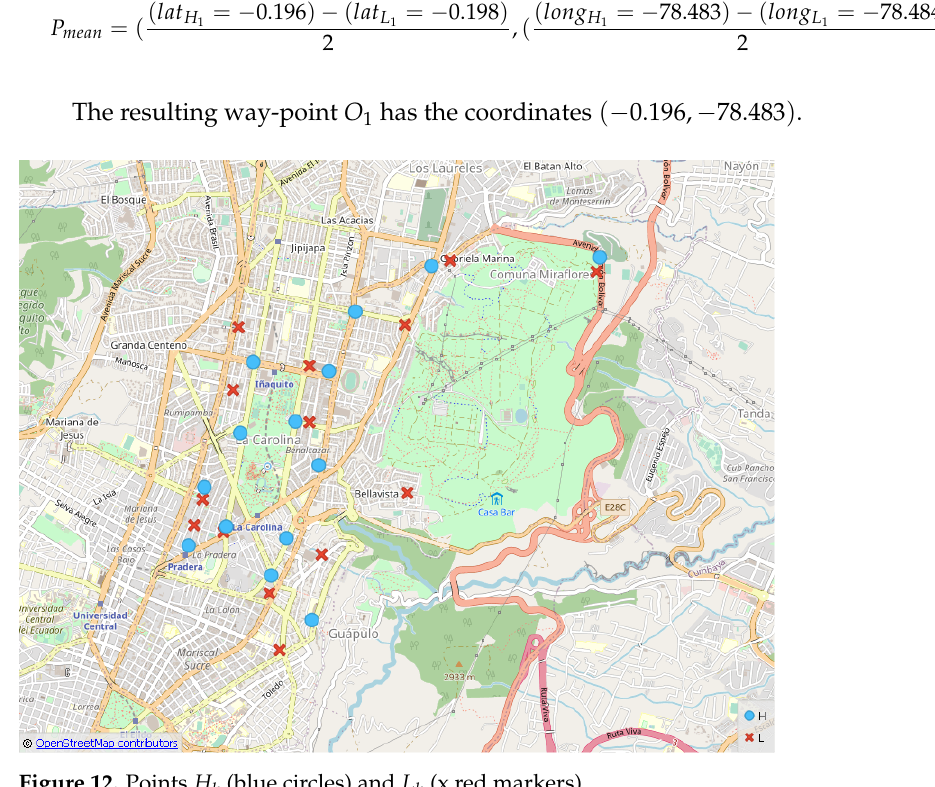
Figure 12. Points H k (blue circles) and L k (x red markers).